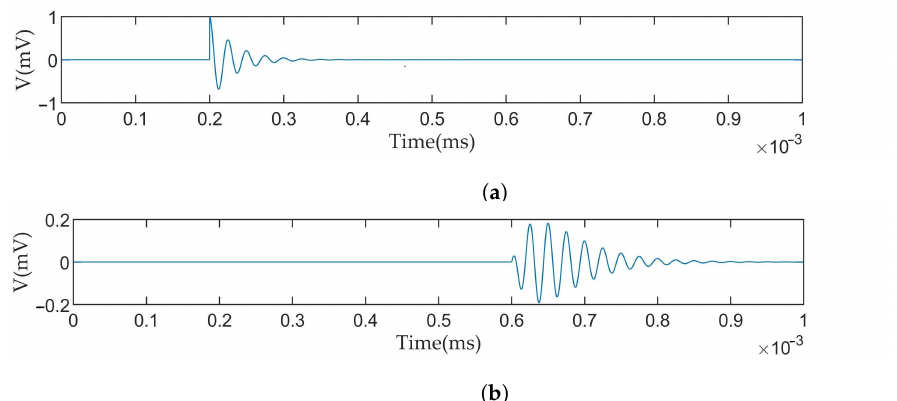
Figure 7. Pulse waveforms of discharge mathematical models: ( a ) SDOP; ( b ) DDOP. The point , air gap, and suspended discharge were all superimposed by SDOP. The frequency of point discharge and air gap discharge is relatively low, the amplitude of the suspended discharge pulse is larger and the attenuation is more intense. DDOP superimposed the surface discharge. Referring to the PD simulation parameters in [26] and fitting the waveforms collected in the experiment, the statistical parameters were obtained to establish the PD source model. The specific parameters are shown in Table 1. Table 1. PD simulation